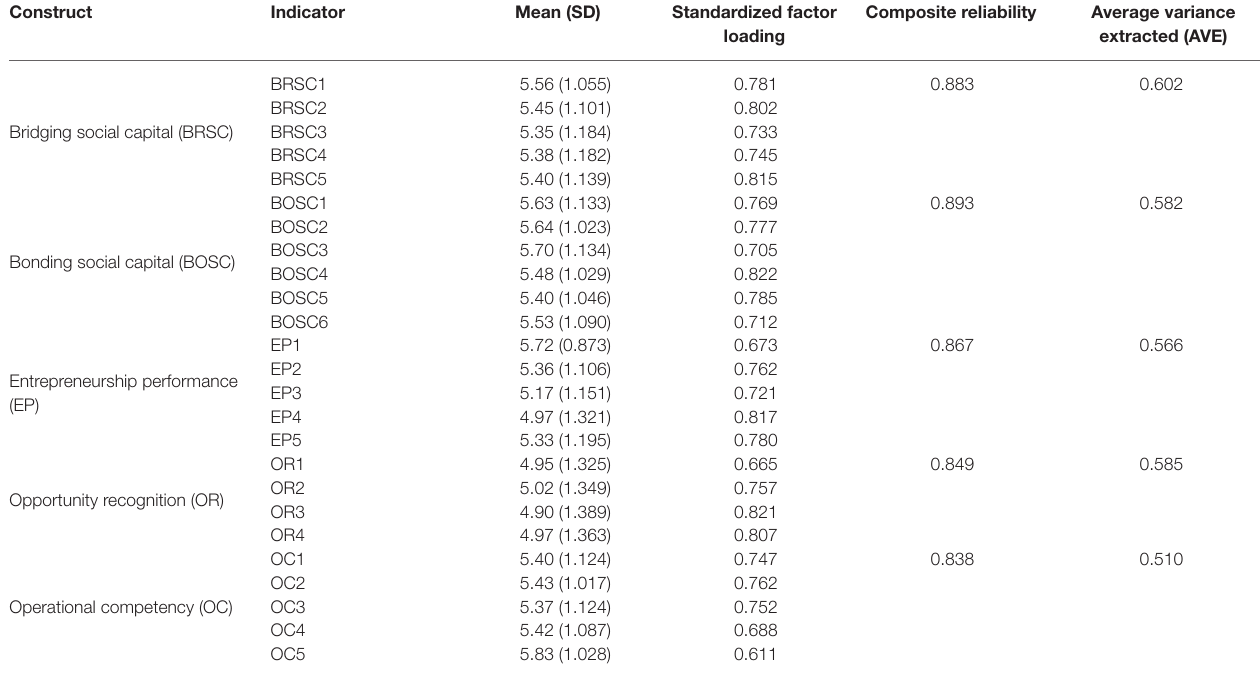
TABLE 2 | Analysis of measurement model results.